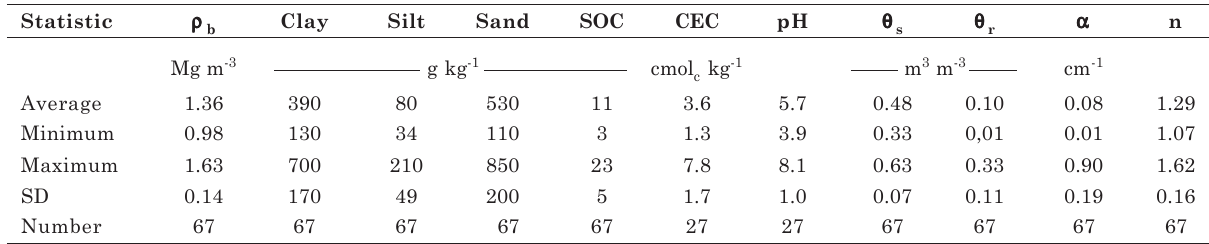
: Bulk density; SOC: soil organic carbon; CEC: cation exchange capacit; θ ρ b content (adjusted), respectively: α and n : empirical parameters of the van Genuchten (1980) model; SD: standard deviation.